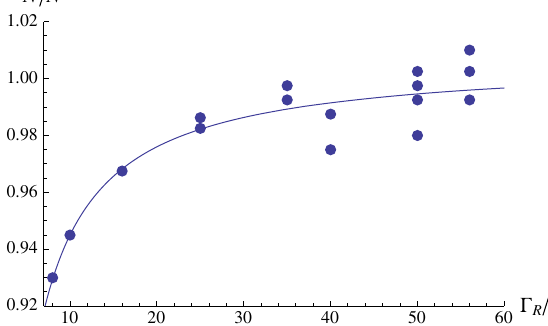
FIG. 4. Scaling of the equilibrium density versus the ratio of the refilling rate Γ to the primary loss rate Γ . The data (blue dots) R P are taken from simulations of 4 × 4 , 5 × 5 , and 6 × 4 lattices with N ϕ ¼ 6 , 8, or 10 and hard-core two-body interactions, for various choices of Ω ∼ Γ [with the refilling rate Γ estimated from S R Eq. (4) with ~ μ ¼ ϵ ], and Γ . Values of N=N (cid:2) > 1 are due to S P incoherent quasiparticle addition above the Laughlin state, which ≪ Γ occurs at a rate Γ , as described in the text. The blue curve E P N=N (cid:2) ¼ 1 . 008 − 0 . 66 Γ = Γ is a numerical fit to the data, P R . R